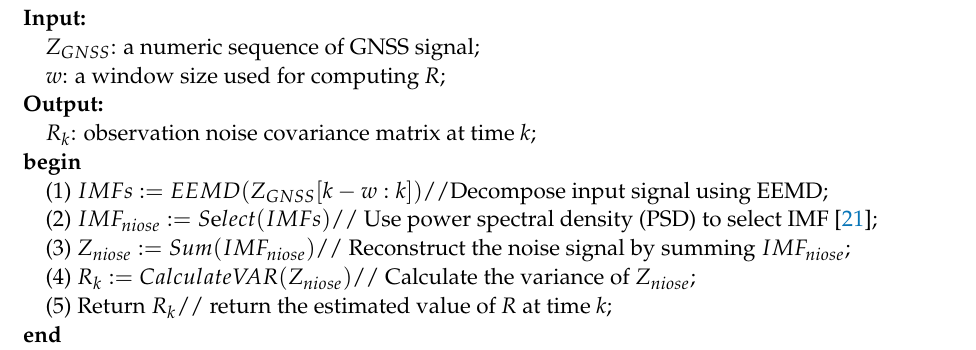
Algorithm 2 f EEMD () : observation noise covariance matrix by